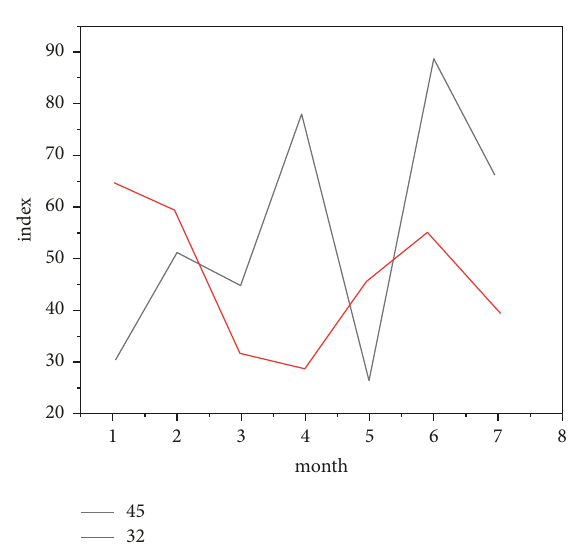
Figure 5: Overseas location trend of cross-border e-commerce